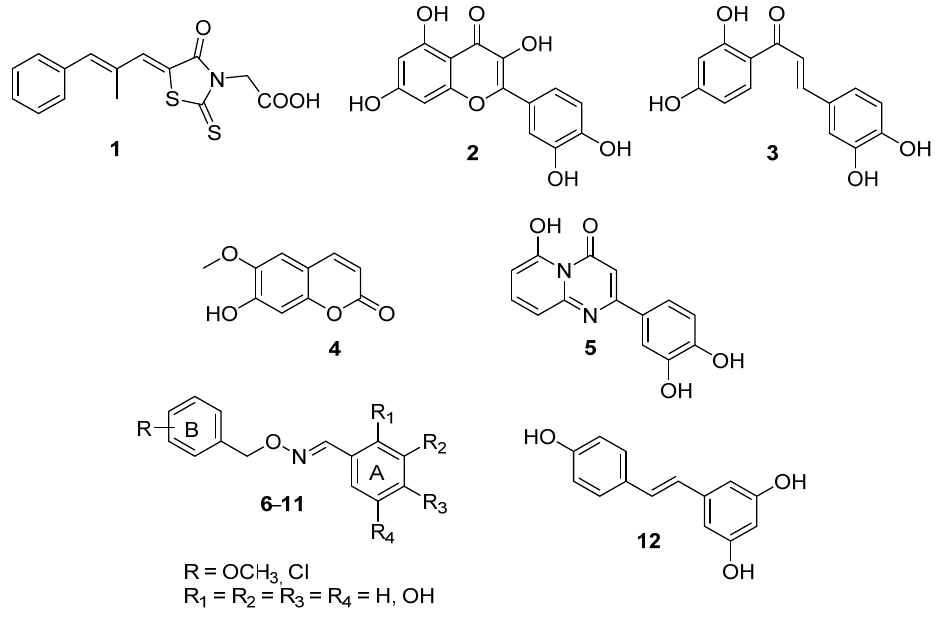
Figure 1. Representative examples of ARIs.